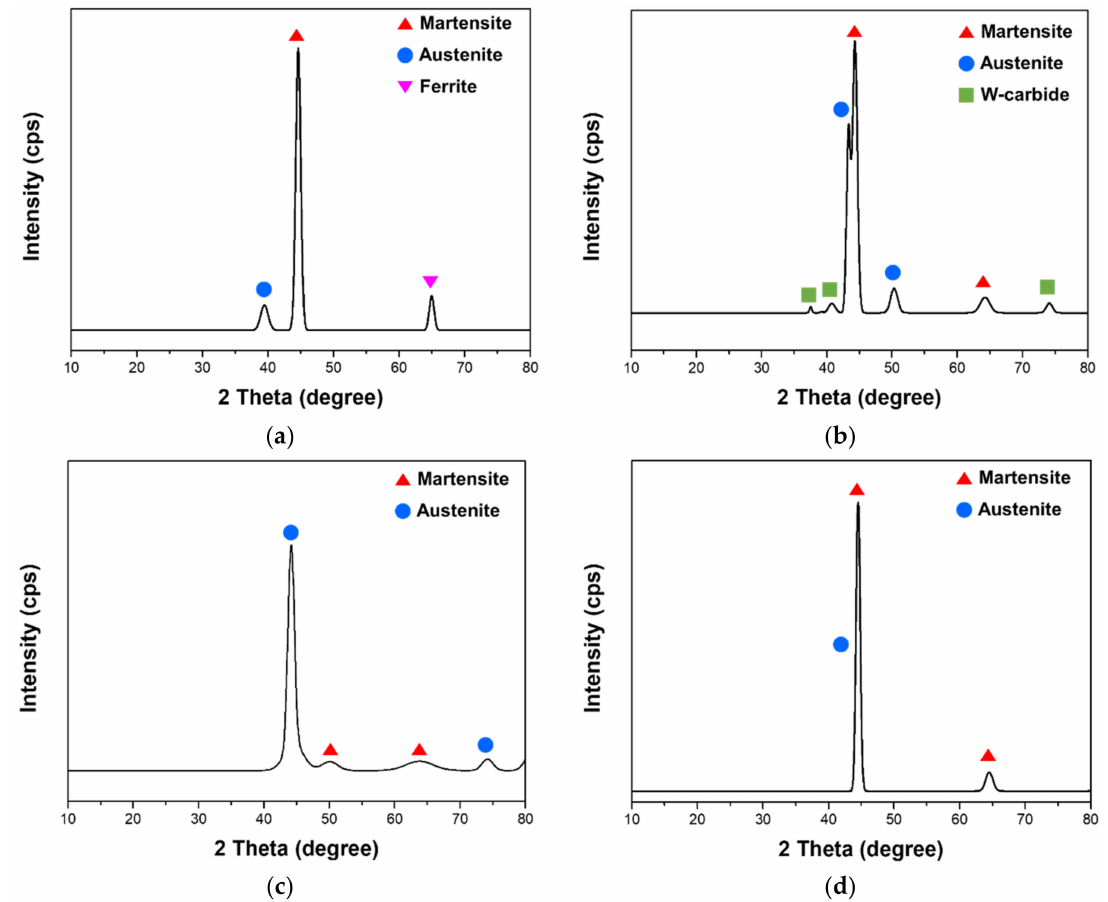
Figure 5. X-ray diffraction patterns of ( a ) C-SCM420, ( b ) as-built (M2), ( c ) as-built (FeCrVMoW) and ( d ) as-built